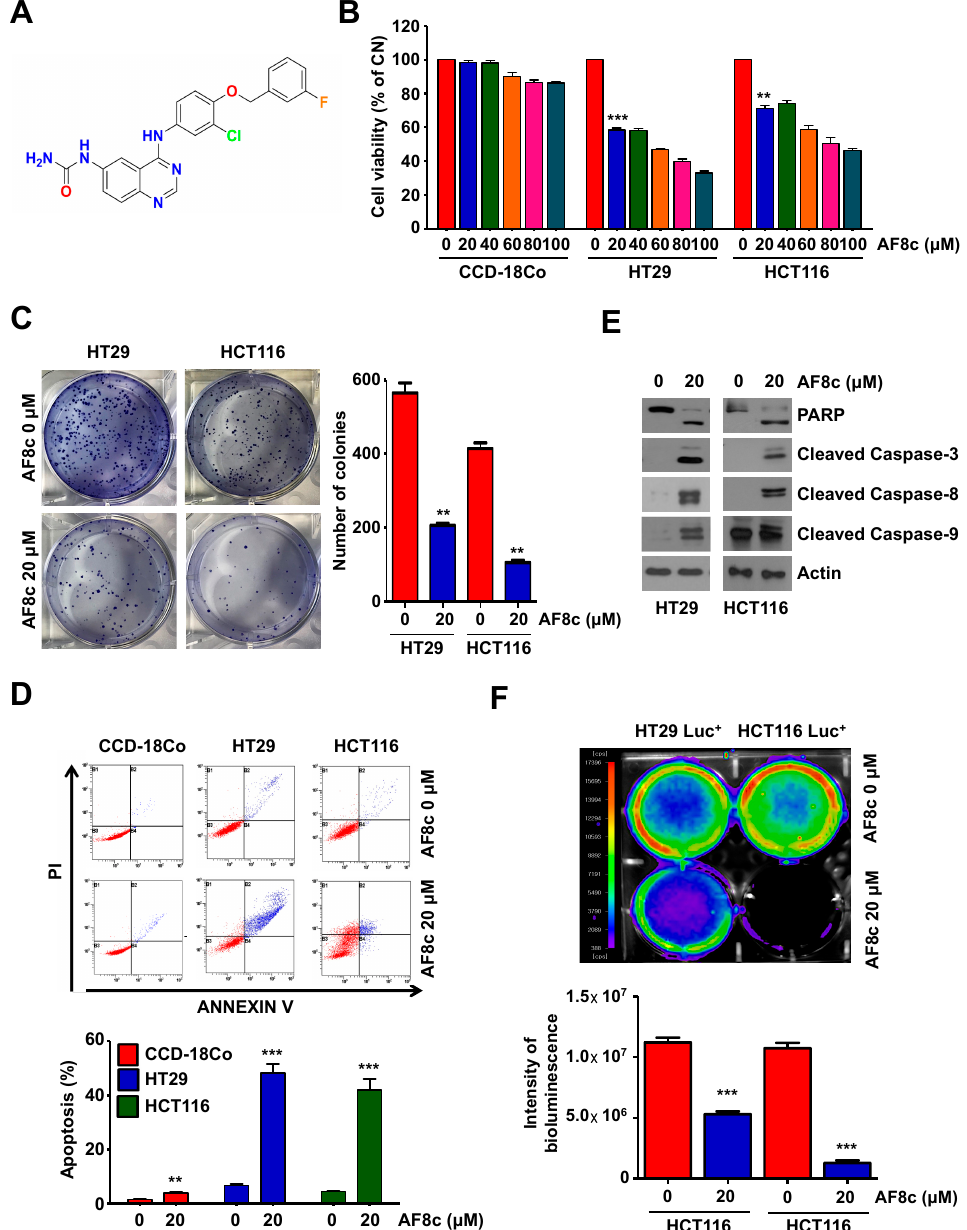
Figure 1. AF8c induces apoptotic cell death in human CRC cells: ( A ) the chemical structure of AF8c; ( B ) normal colon CCD-18Co (left), CRC HT29 (middle), and HCT116 (right) cells were treated with 0–100 μ M AF8c for 24 h, and cell viability was then assessed using the WST-1 assay. **, p < 0.01 and ***, p < 0.001; ( C ) after treatment with DMSO or 20 μ M AF8c, cells were stained with crystal violet and imaged (left); the graph (right) is a quantification of colony formation. **, p < 0.01; ( D ) Cells were incubated with 20 μ M AF8c for 24 h and then analyzed using flow cytometry after staining with Annexin V and PI; ( E ) HT29 (left) and HCT116 (right) cells were treated with AF8c for 24 h, and the expression levels of apoptosis-associated proteins were determined by immunoblotting; confirma- tion experiments: HT29 (left) and HCT116 (right) cells were pretreated with Z-VAD-fmk for 1 h, then treated with AF8c for 24 h, and the caspase cascade was confirmed by Western blot; ( F ) HT29 Luc + (left) and HCT116 Luc + (right) cells were plated in 6-well plates and then treated with 20 μ M AF8c. Images were obtained using the charge-coupled camera of the in vivo imaging system (upper) and quantified (lower). ***, p < 0.001. 2. Materials and Methods